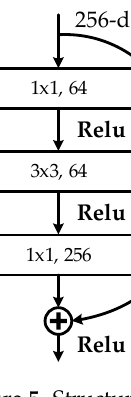
Figure 5. Structure of the bottleneck .